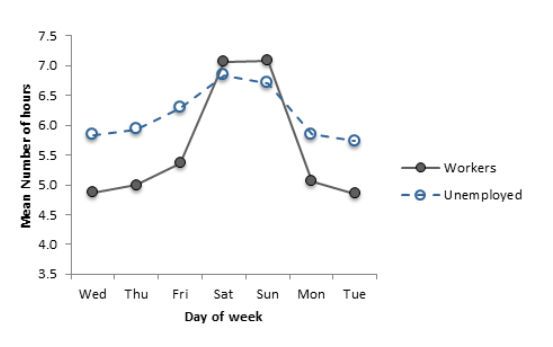
Figure 5: Social hours by day of week. From Gallup Daily Poll,